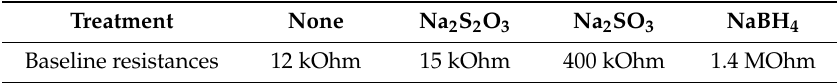
Figure 8. Ammonia sensing test: ( a ) electric resistance changes and ( b ) response of the as grown PPy sensor and PPy sensors after reduction treatments in Na 2 S 2 O 3, Na 2 SO 3 and NaBH 4 10 wt% solution in demineralized water. Table 2. Electrical resistances of PPy based sensors and reduced PPy based sensors.